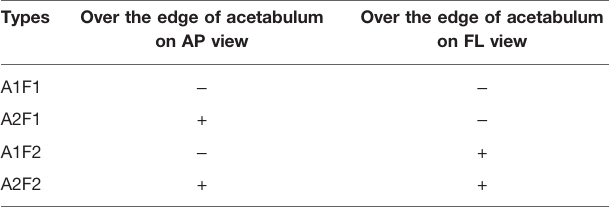
TABLE 1 | Classi fi cation criteria based on range of necrotic lesion.